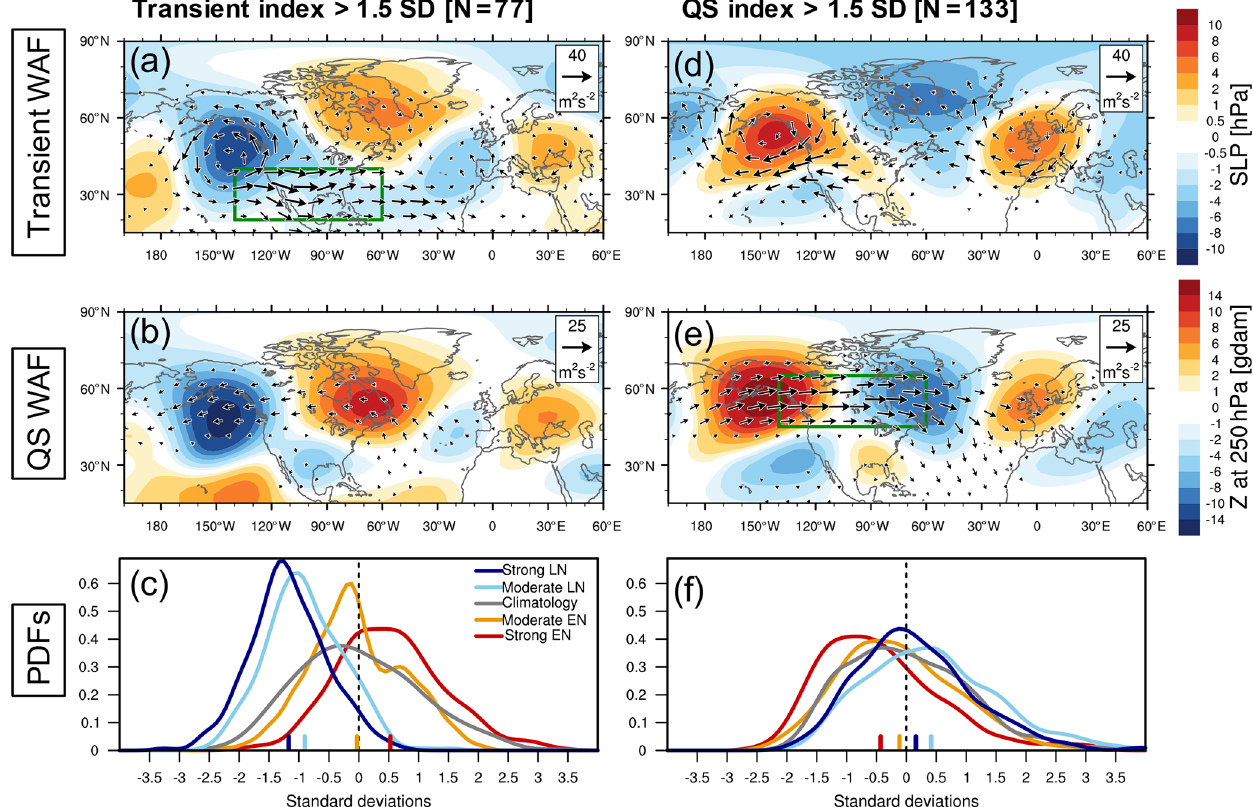
Figure 9. December to March monthly mean anomaly composites of (a, d) SLP (color shading) and transient WAF (arrows) and (b, e) Z250 (shading) and QS WAF (arrows), for months when an anomalously strong eastward WAF of (a, b) transient eddies and (d, e) QS ( k = 1–3) waves occur. Events are defined using a threshold of 1.5SD for each of the indices. At the top, values in brackets indicate the total number of months considered in each composite. Green boxes indicate the regions where the eastward component of the WAF has been averaged for (a) transient and (e) QS waves. The PDF of the December to March standardized monthly means for (c) the M x index and (f) the F x index. Colors indicate different ENSO forcings (red: strong EN, orange: moderate EN, grey: climatology, light blue: moderate LN, dark blue: strong